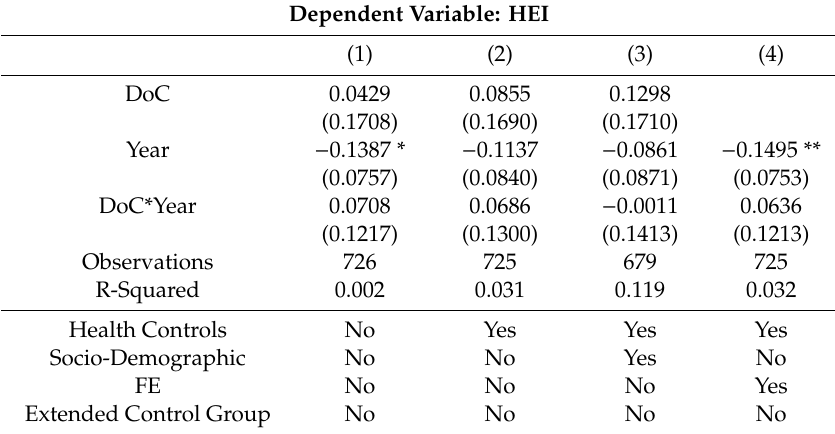
Table 7. Di ff erence-in-di ff erence with users in both years as